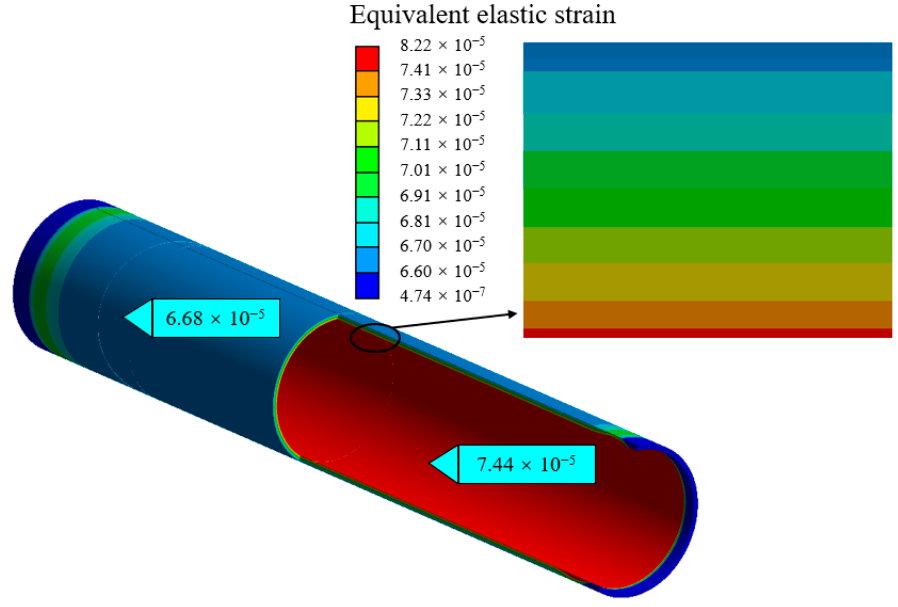
Figure 8. Distribution of equivalent elastic strain on pipeline wall.